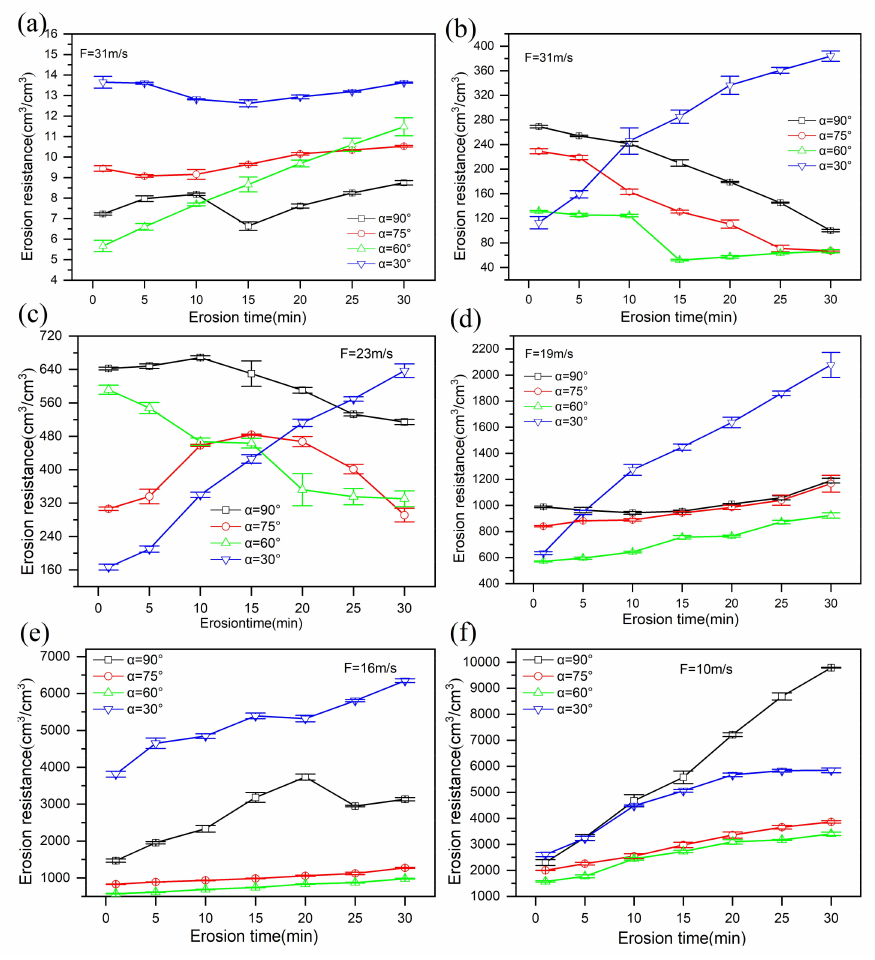
Figure 14. Development curve of wind erosion resistance with wind erosion time: ( a ) remolded soil; ( b ) improved soil ( c ) improved soil; ( d ) improved soil; ( e ) improved soil; ( f ) improved